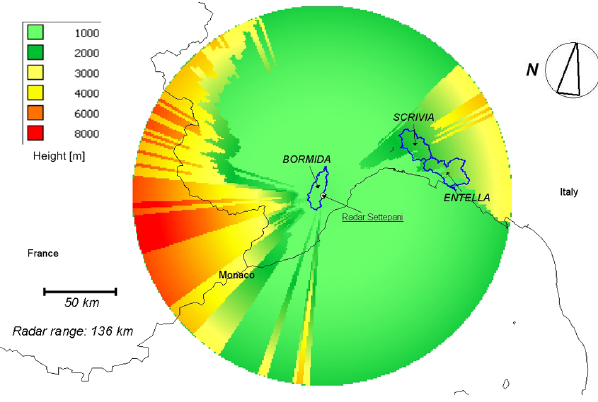
Fig. 1. Study area. The Settepani radar location is reported together with the height of visibility at each point of the area covered. The three basins with a drainage area larger than 150km 2 are reported. Minor basins are located between Bormida and Entella basins, in an area where the height of visibility is generally lower than 2000–